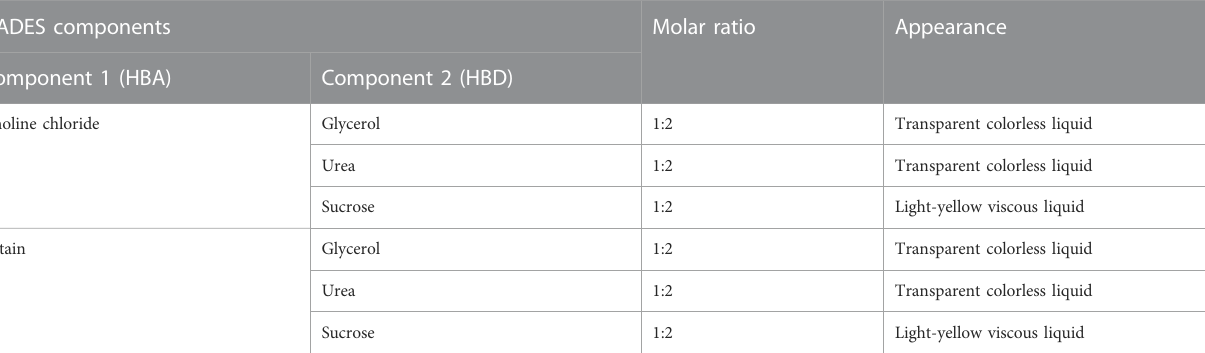
TABLE 1 NADES preparation for extraction. NADES